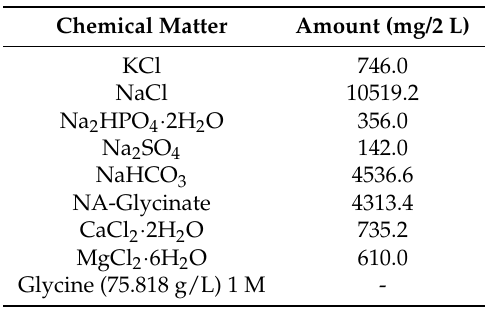
Table 4. Inorganic salts in simulated body fluid (SBF)